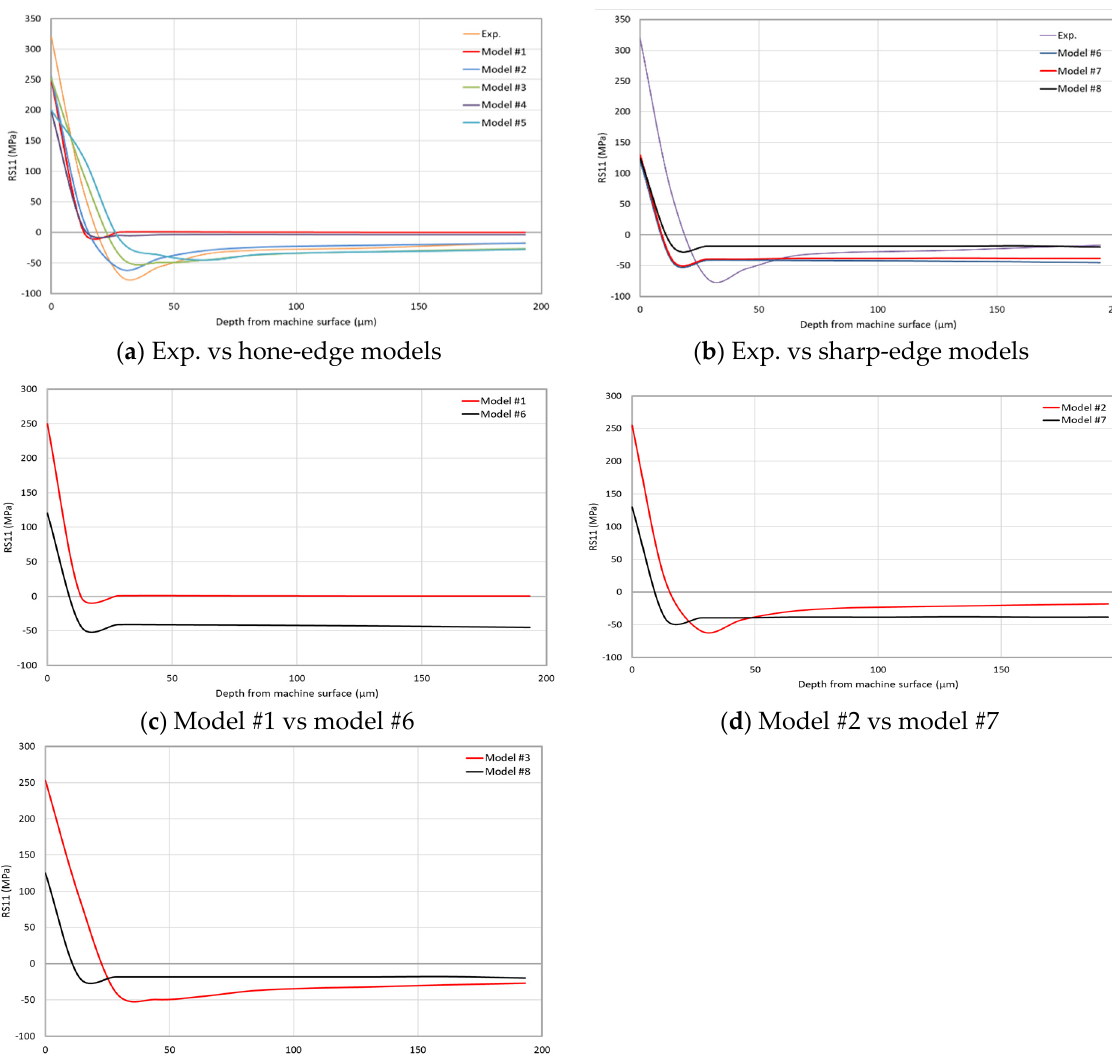
Figure 8. In-depth RSs’ distribution in the cutting direction ( RS11 )—FEA models.